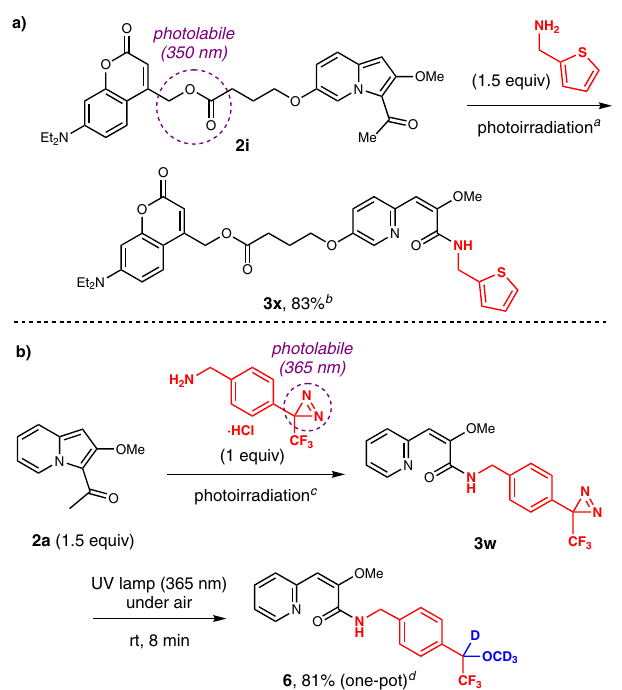
Fig. 4 Wavelength-selective photoreactions. Photoconjugation with substrates bearing photoreactive (coumarin-4-yl)methyl ester ( a ) and diazirinyl ( b ) moieties. a Red light-emitting diode (LED) (660nm), methylene blue (1mol %), MeCN, under air, room temperature, 3min. b Isolated yield. c Red LED (660nm), methylene blue (1mol %), Na 2 CO 3 (1 equiv), PhCF 3 (internal standard, 1 equiv), methanol- d 4 /water- d 2 (13/1), under air, room temperature, 3 min. d Yield determined by 19 F NMR measurement.